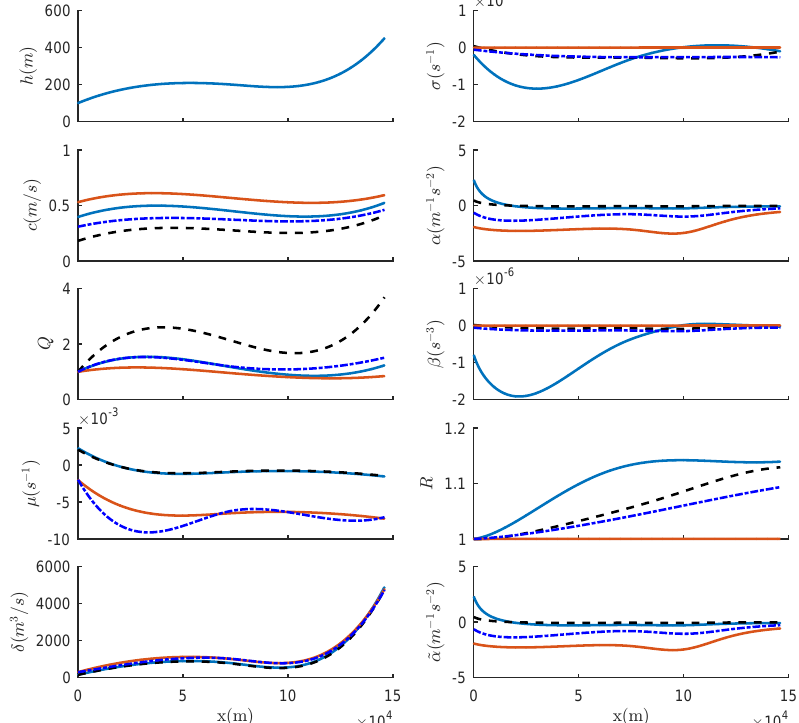
Figure 12. Variation of the original coefficients (left panel and top of the right panel) and the derived coefficients (remainder of the right panel) of the vKdV equation for conditions along the Malvinas Current case. The results show the coefficients in summer with background current u 0 (blue, solid), without u 0 (black, dash) and the coefficients in winter with u 0 (red, solid), without u 0 (blue,